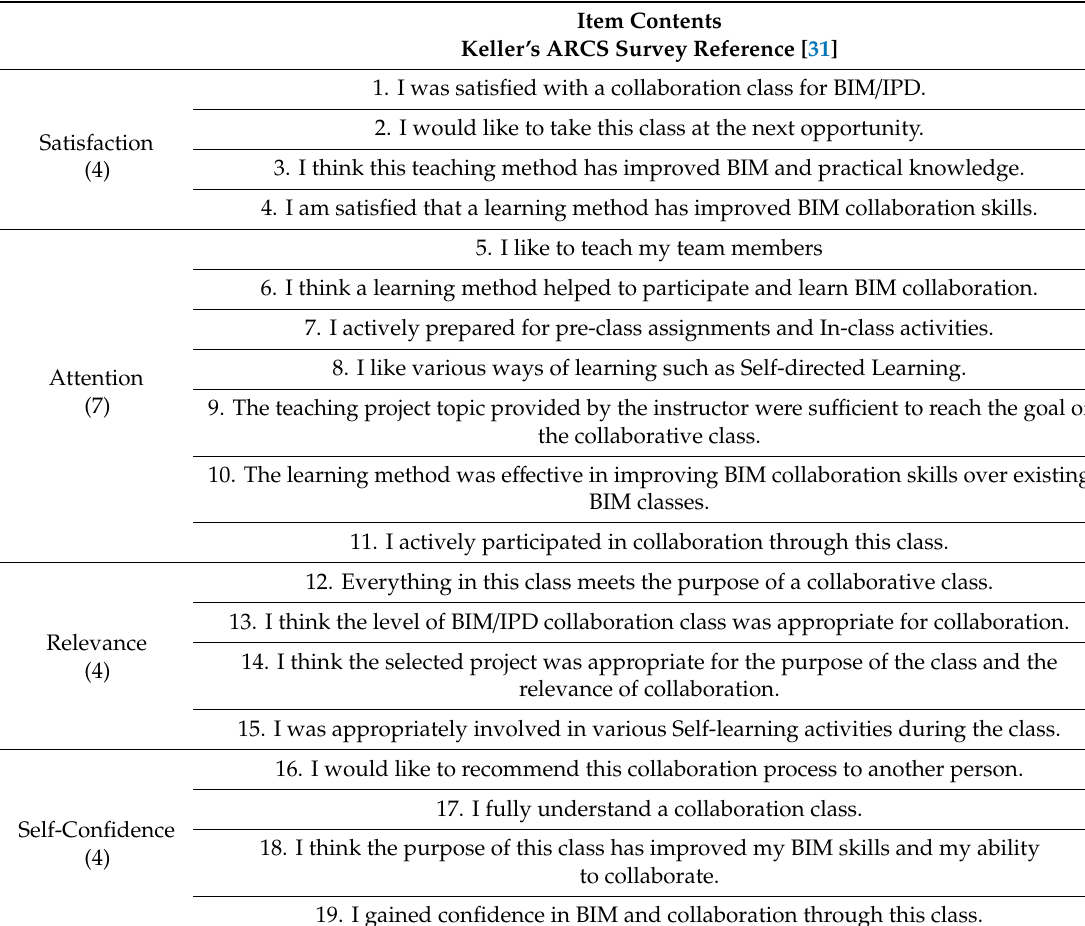
Table 9. Training Satisfaction Questionnaire for collaborative